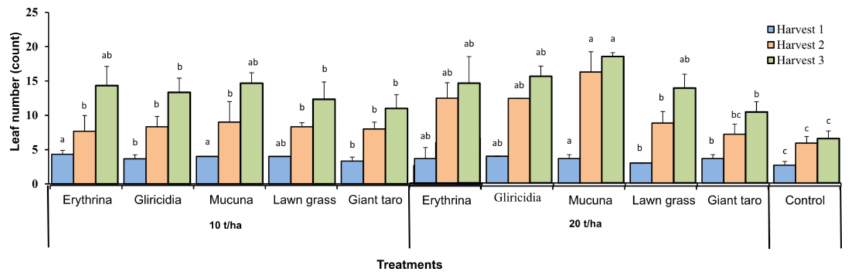
Figure 2. Interaction effect of organic amendments and their application rates (10 and 20 t ha − 1 ) on leaf number (count) of Chinese cabbage ( B. rapa cv. Chinensis) harvested at 14, 28 and 42 days after transplantation. Treatments having different lowercase letters are significantly different from each other at p <